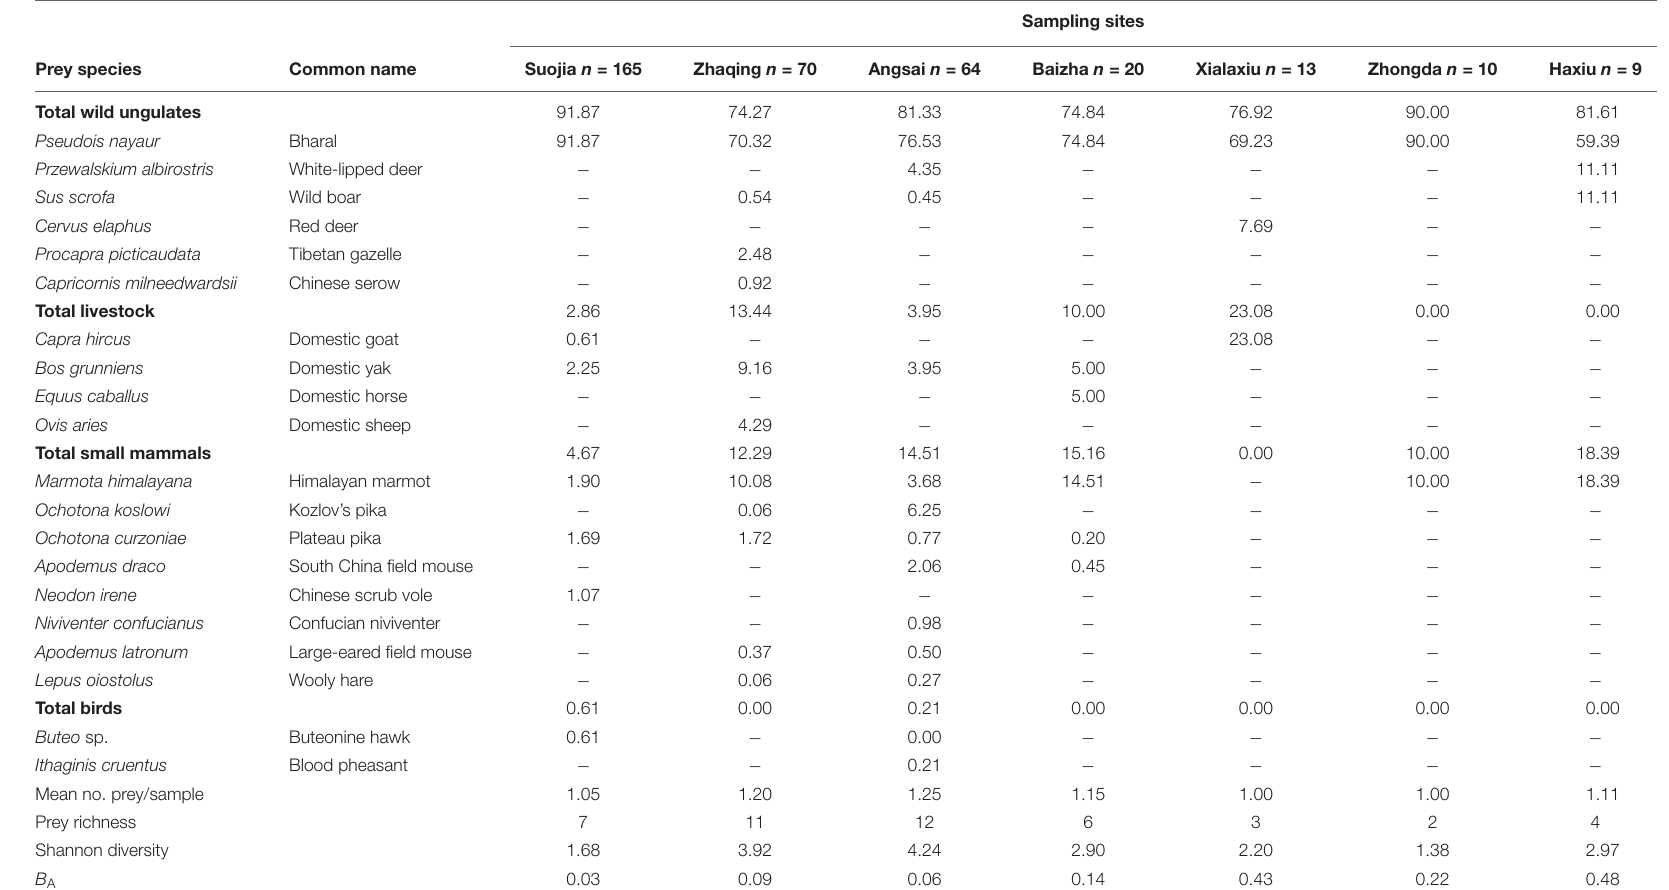
TABLE 1 | Snow leopard dietary compositions, presented as mean values of relative read abundance (RRA) of individual prey species, at seven sampling sites.